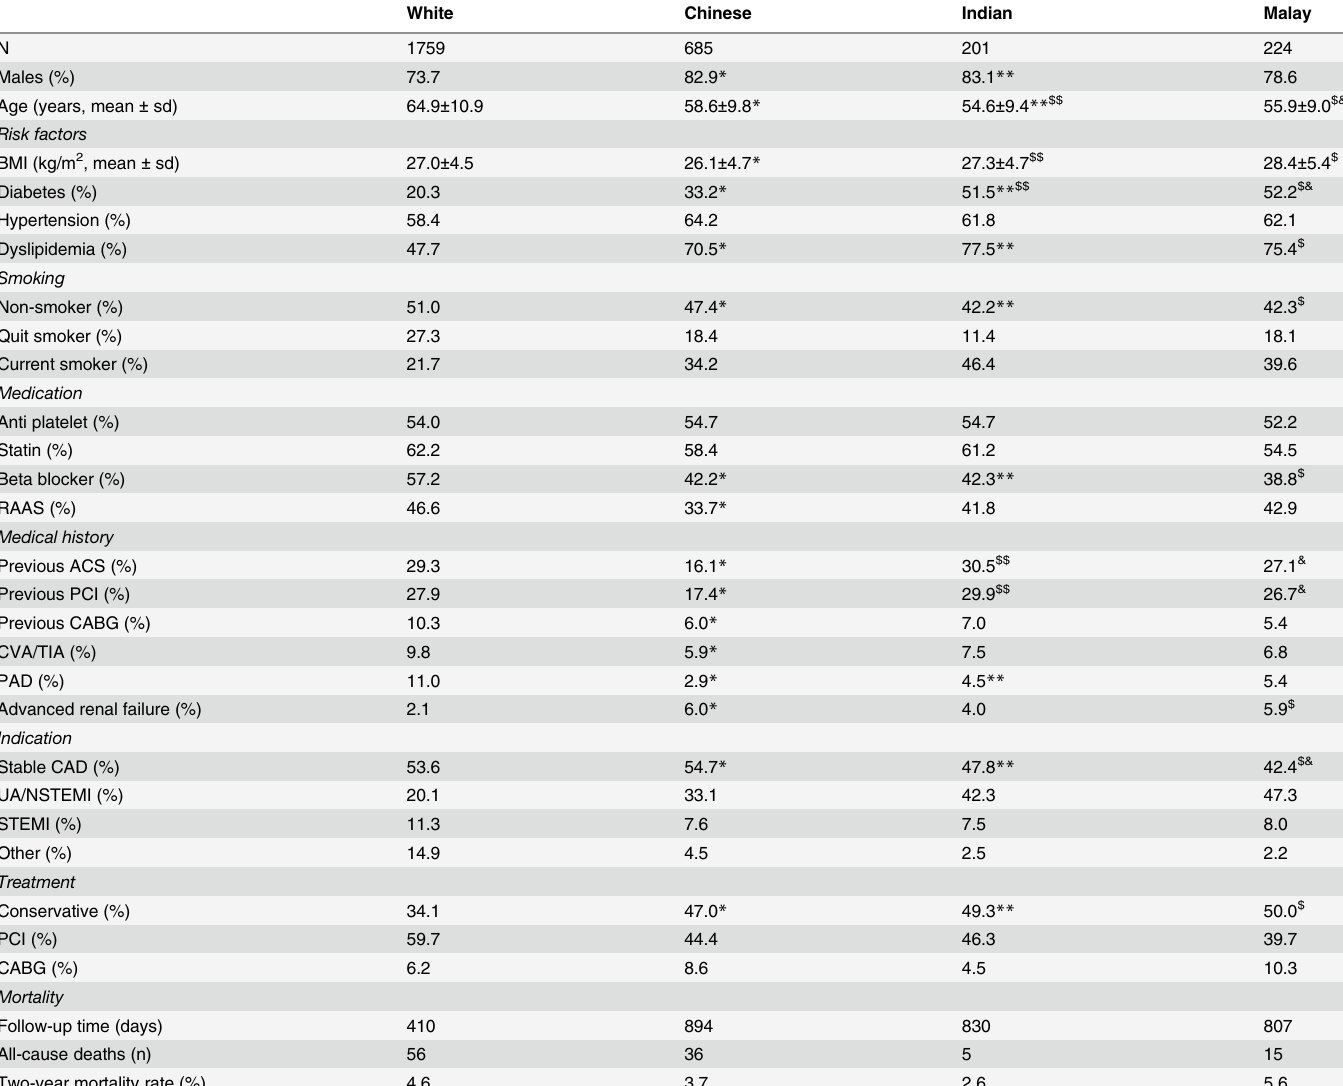
Table 1. Demographic and Clinical Characteristics of the UNICORN cohorts by Ethnicity. White Chinese